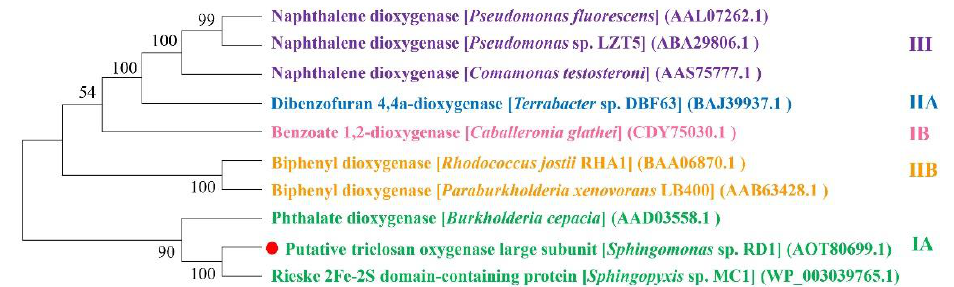
Figure 4. Unrooted phylogenetic tree generated based on amino acid sequences of the large subunit of putative TCS oxygenase [103]. Rieske-type aromatic dioxygenases divided into the same group are represented by the same color. The reference sequences are shown in [107–110]. The putative TCS oxygenase large subunit analyses of strain Sphingomonas sp. RD1 are marked with a red circle.